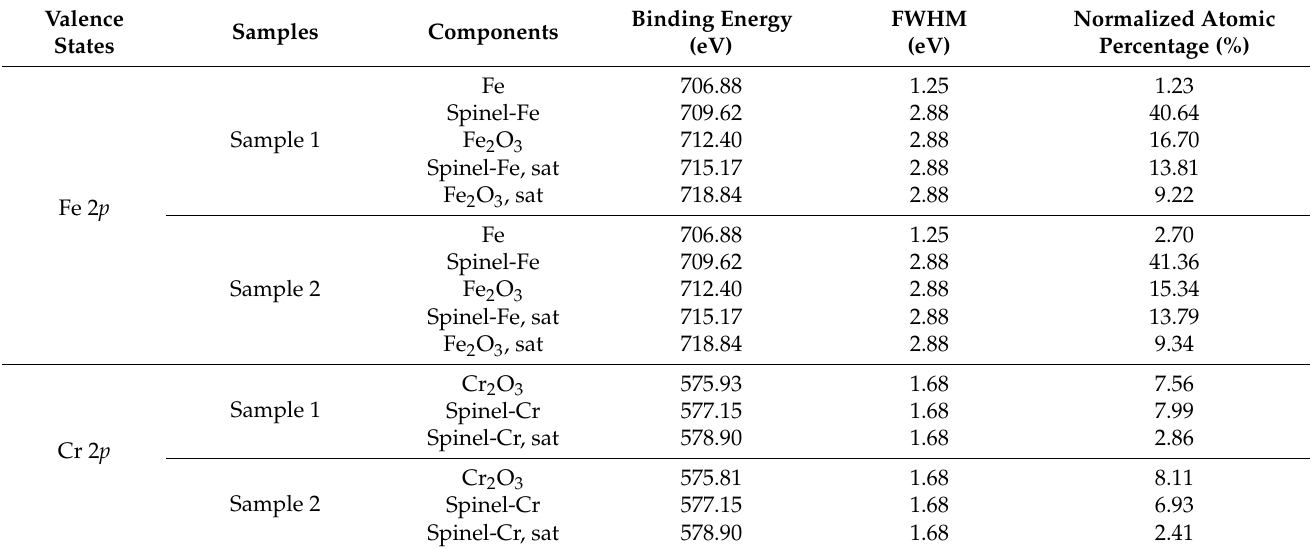
Table 2. Fe 2 p and Cr 2 p peak-fitting